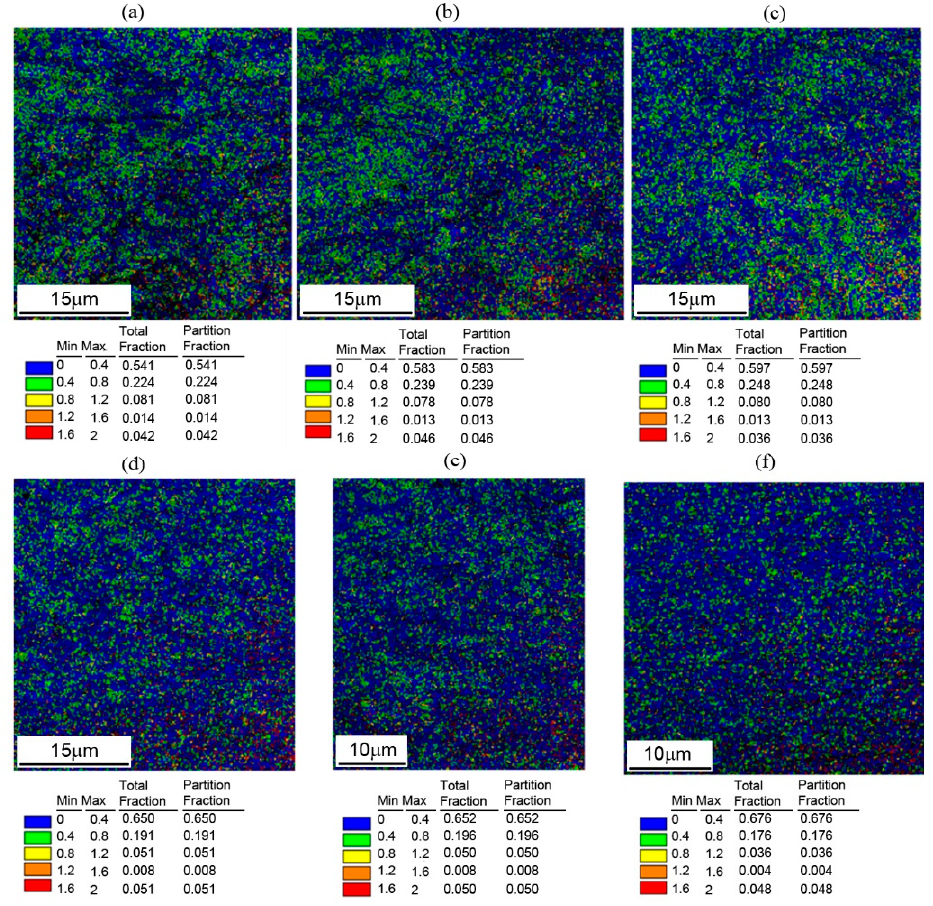
Figure 3. Kernel average misorientation (KAM) distribution maps in HSLA steel specimens deformed with total strains of 2 ( a ), 5 ( b ), 7 ( c ), 10 ( d ), 15 ( e ) and 20 ( f ).